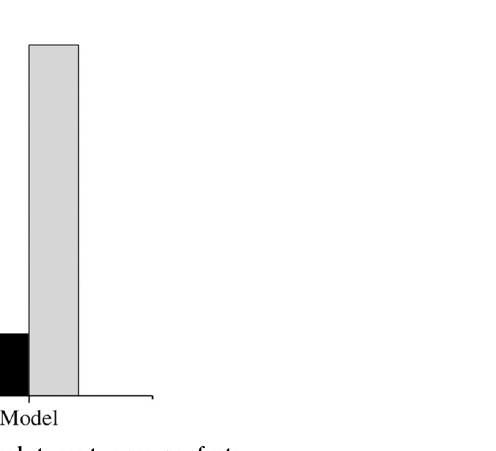
Fig 1. Comparison of blood biochemical indexes between two groups of